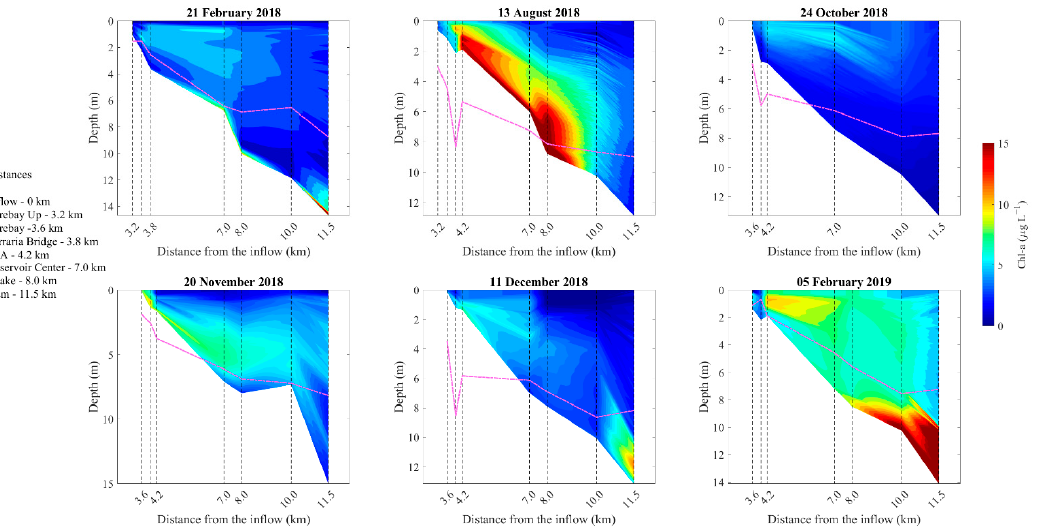
Figure 4. Contour plots of chla concentrations along a cross section of Passaúna Reservoir observed during different sampling campaigns (the sampling date is indicated in the title of each panel). The y -axis is depth, and the x -axis is the distance along the longitudinal. The location of the sampling sites at which vertical profiles with the FluoroProbe sensor were measured is indicated by black dashed vertical lines. The profiles were interpolated along the longitudinal direction. The magenta dashed line shows the estimated depth of the euphotic zone. During the lab analysis, it was observed that the samples collected below the eupho- tic zone had a brownish color, indicating that at least part of the phytoplankton was dead. The pattern of larger concentrations in deeper layers was also observed for nutrient con- centrations (Figure 3). 3.3. Spatial Variations of Chla at the Water Surface The three longitudinal transects had the highest concentrations between the forebay and the side arm with the Ferraria River, with the highest chla concentrations in February 2019 and the lowest in August 2018 (Figure 5).